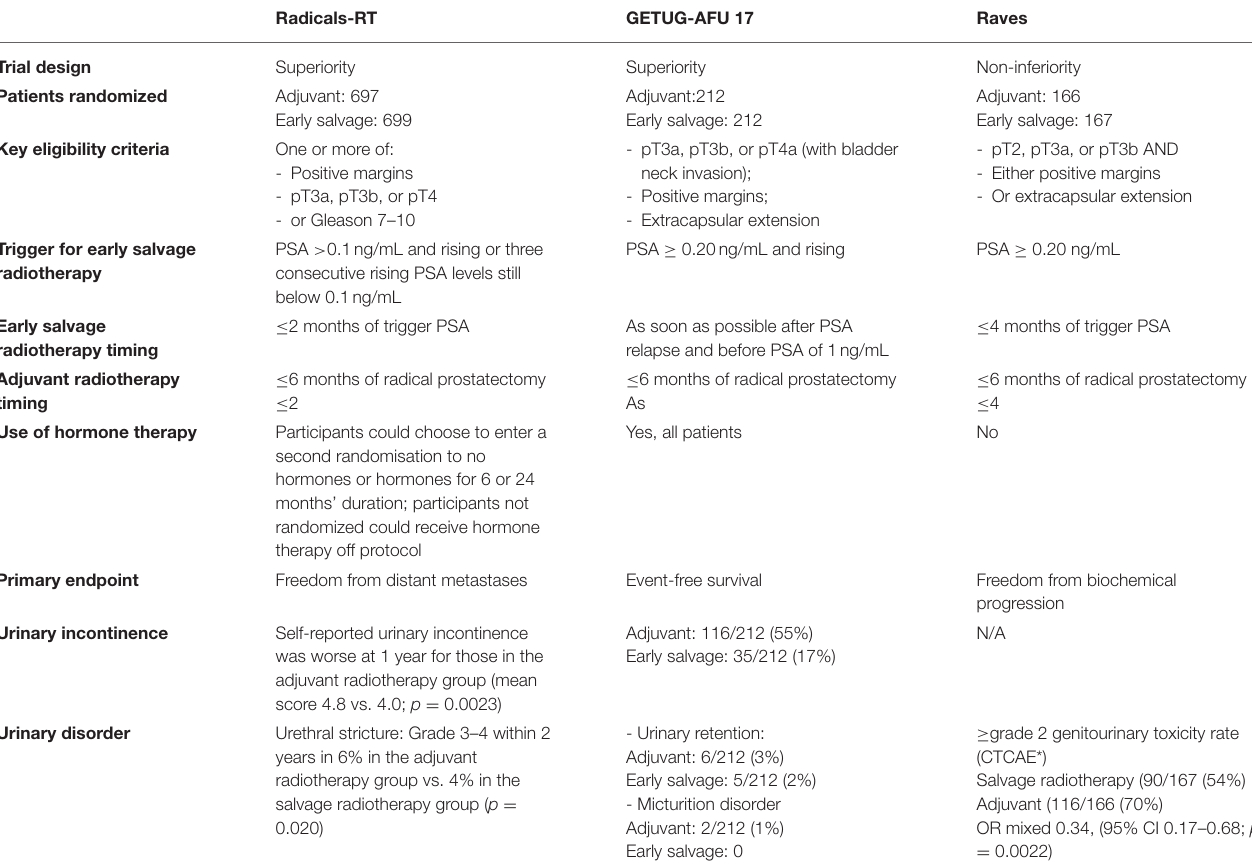
TABLE 1 | Summary of recently published randomized trials for